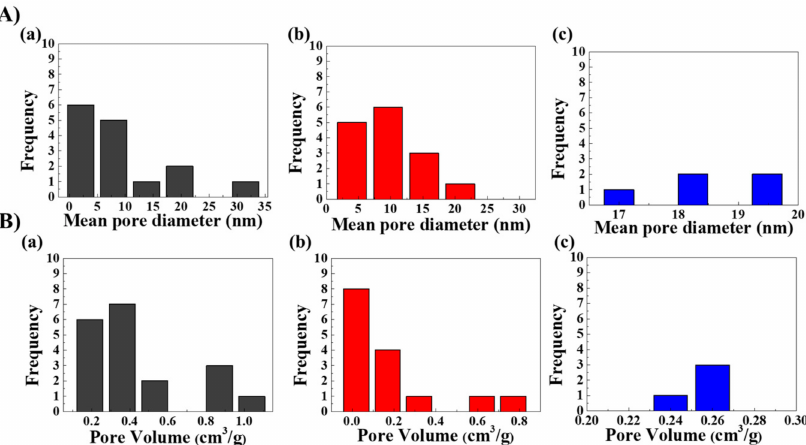
Figure 2. Histograms for the ( A ) mean pore diameter and ( B ) pore volume depending on metal composition. ( a ) MgAl-MMO, ( b ) ZnAl-MMO, and ( c )